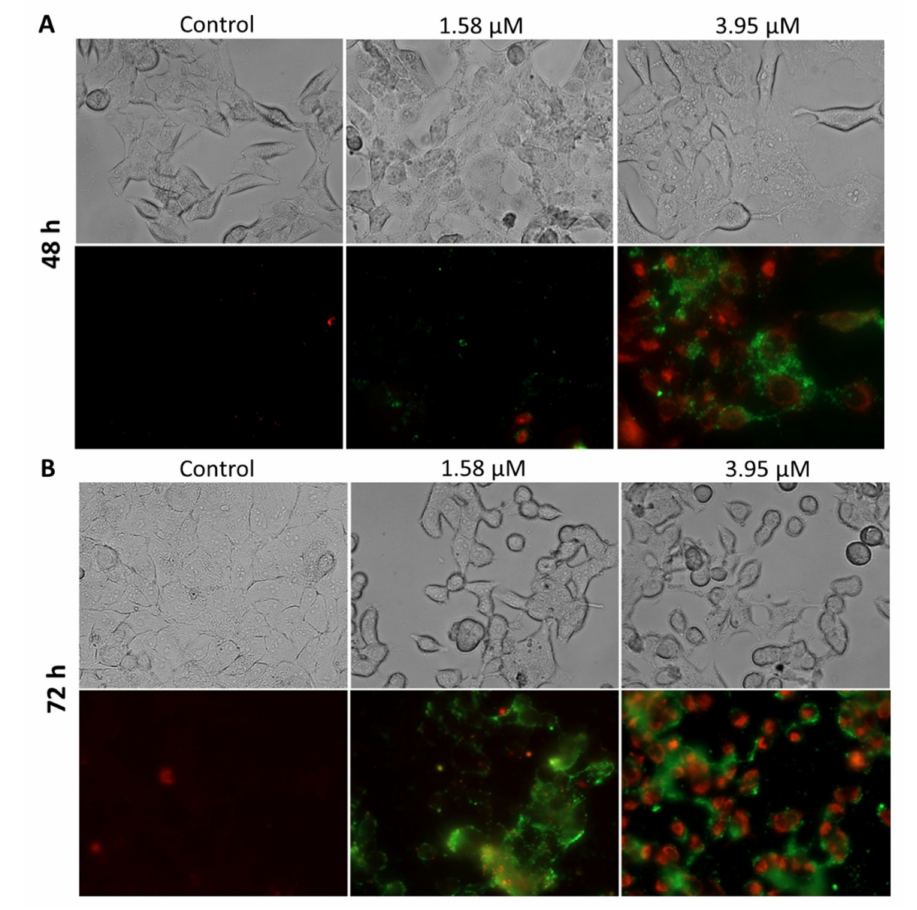
Figure 6. Detection of apoptosis induced by compound 5f in ductal adenocarcinoma cancer cell line CFPAC-1 using Annexin V assay after 48 ( A ) and 72 ( B ) hours of treatment at concentrations of 2 × IC 50 (1.58 µ M) and 5 × IC 50 (3.95 µ M). Cells were visualized by fluorescence microscope using 40